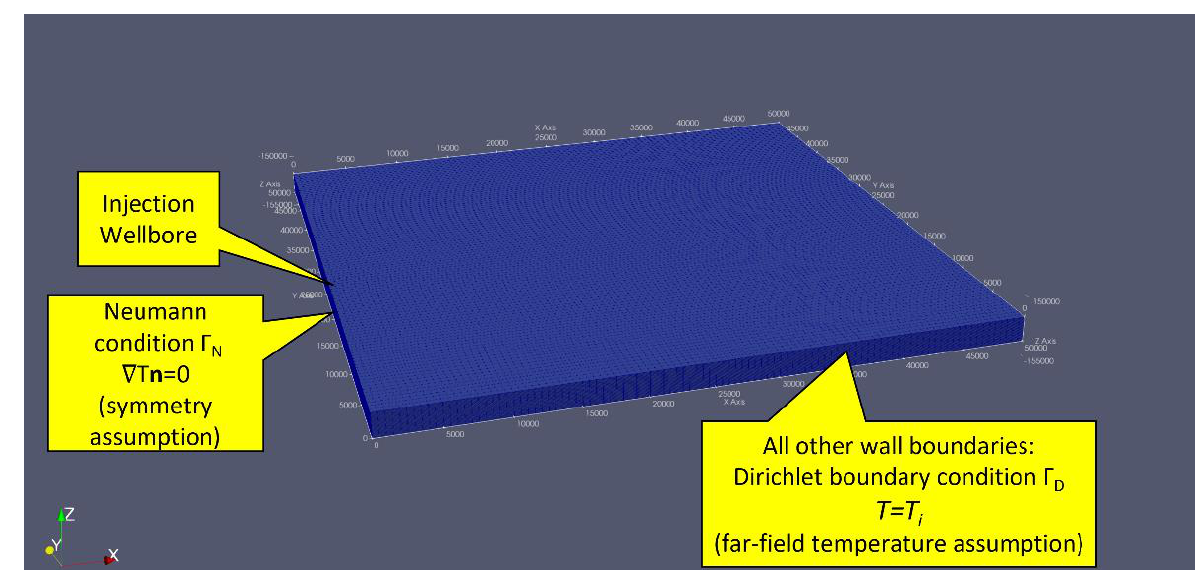
Figure 3. A mesh representing a 500 square-meter area of the Frio Formation. A Neumann boundary condition is imposed on the y-z plane at x = 0, such that the temperature gradient is 0 to implement a symmetry assumption on that wall. All other walls have a Dirichlet boundary condition of T = T i imposed to implement a far-field constant reservoir temperature assumption. The simulated injec- tio n wellbore perforation interval was configured to −1527.5 m to −1533.75 m with respect to the z - axis at a y -axis location of 500 m. The injection fluid and reservoir initial temperature was configured